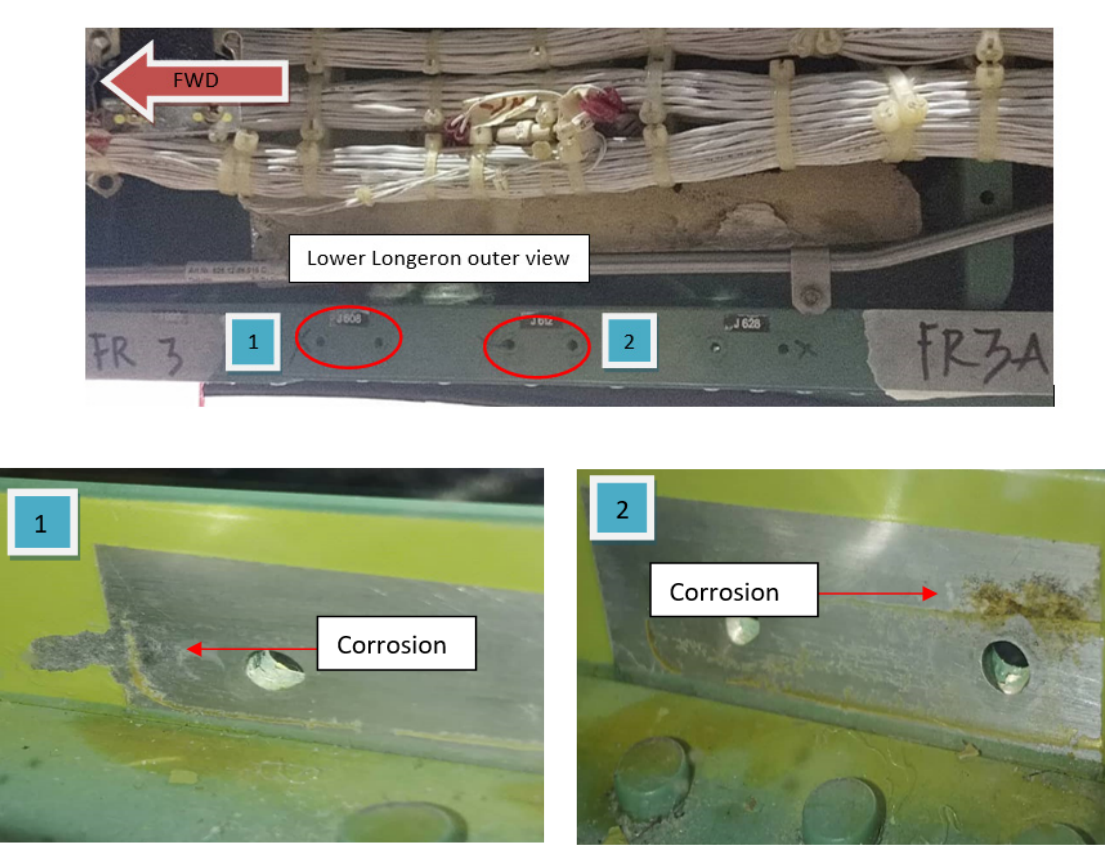
Figure 5. Intergranular corrosion on upper longeron.